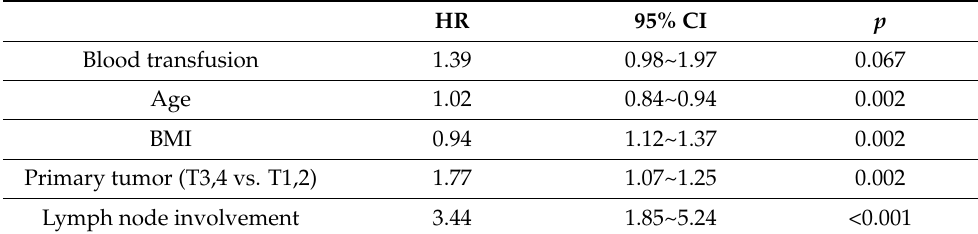
Table 4. Forward model selection for overall survival before